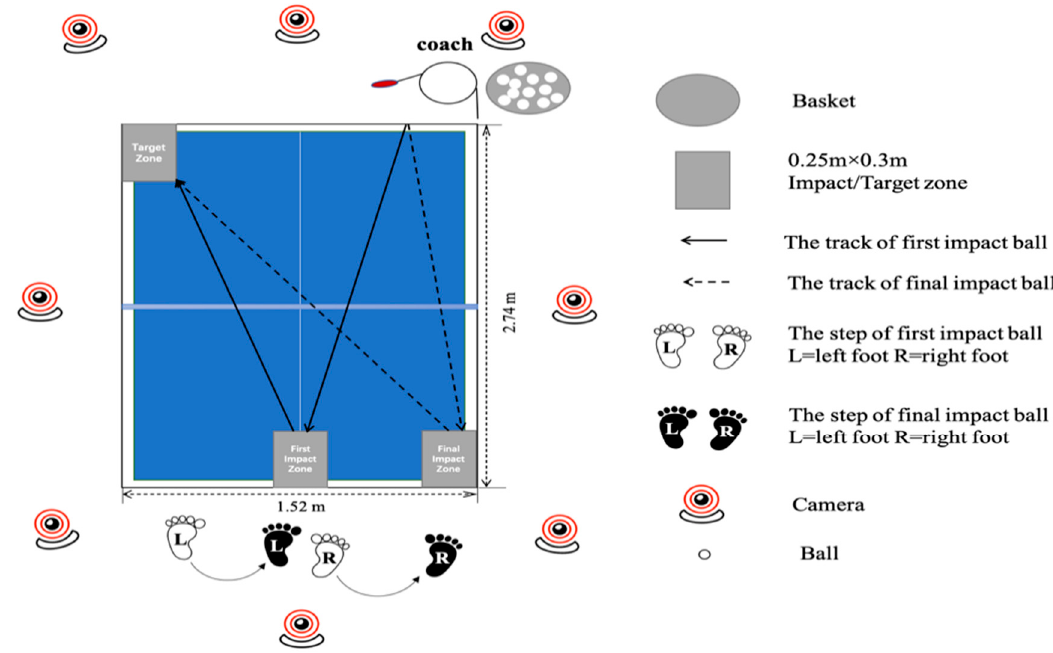
Figure 1. Experimental set up including the backward phase (BP) and forward phase (FP) during the chasse step.